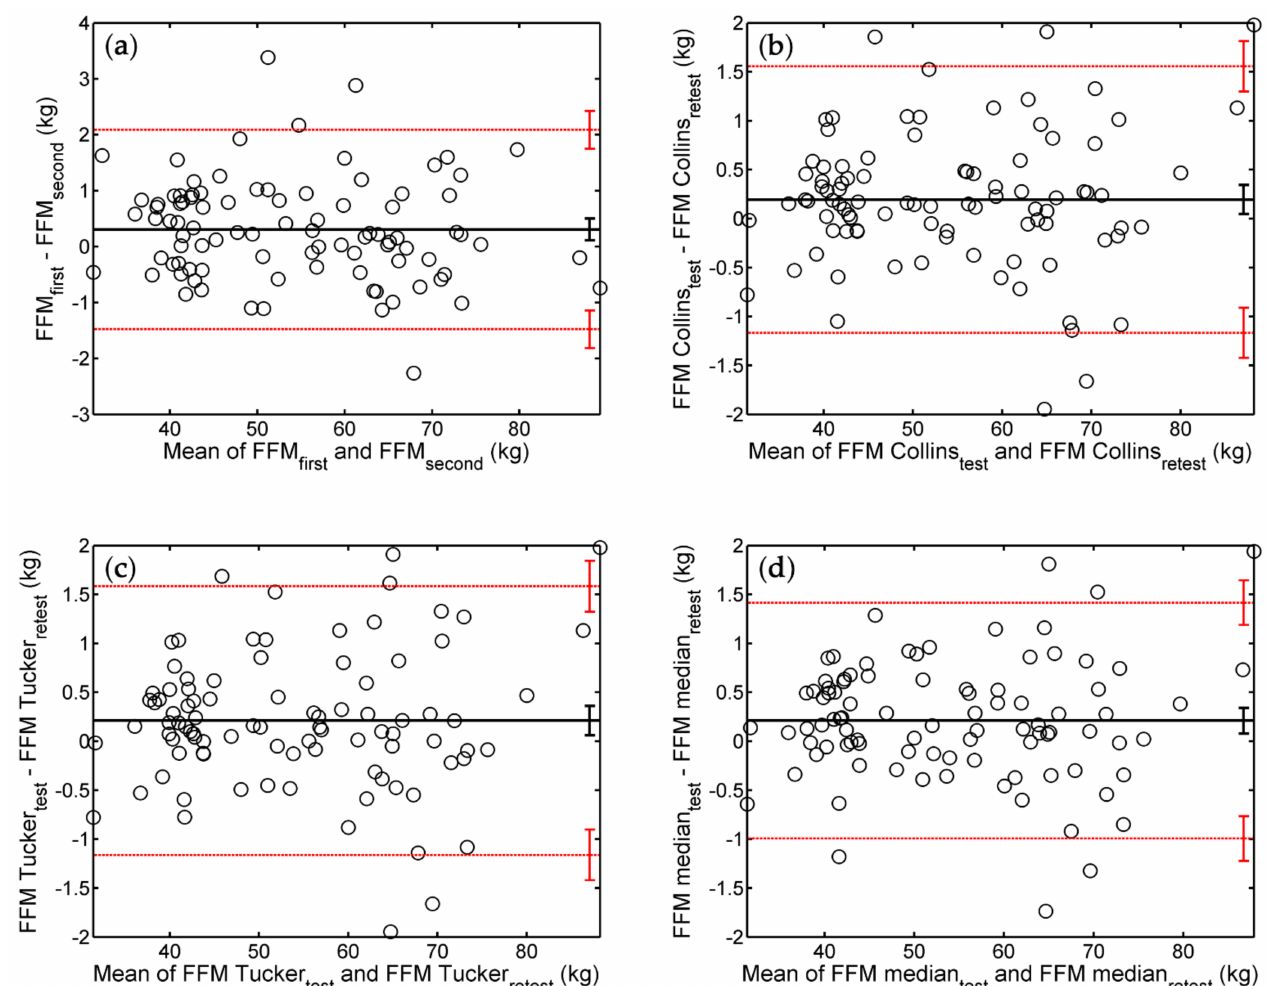
Figure 2. BA analysis of the reliability of FFM assessments via different protocols. The shown BA plots correspond to test–retest pairs of values obtained using ( a ) individual ADP trials, ( b ) the Collins protocol, ( c ) the Tucker protocol, and ( d ) the median protocol. Notations are explained in the caption of Figure